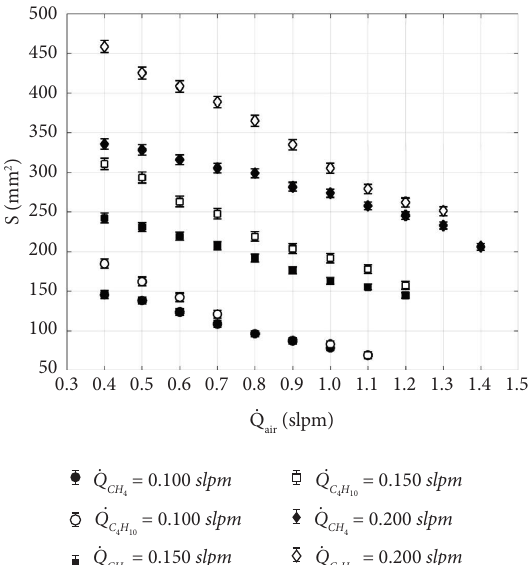
Figure 15: Variation of fame area with the airfow rate for methane and n-butane.